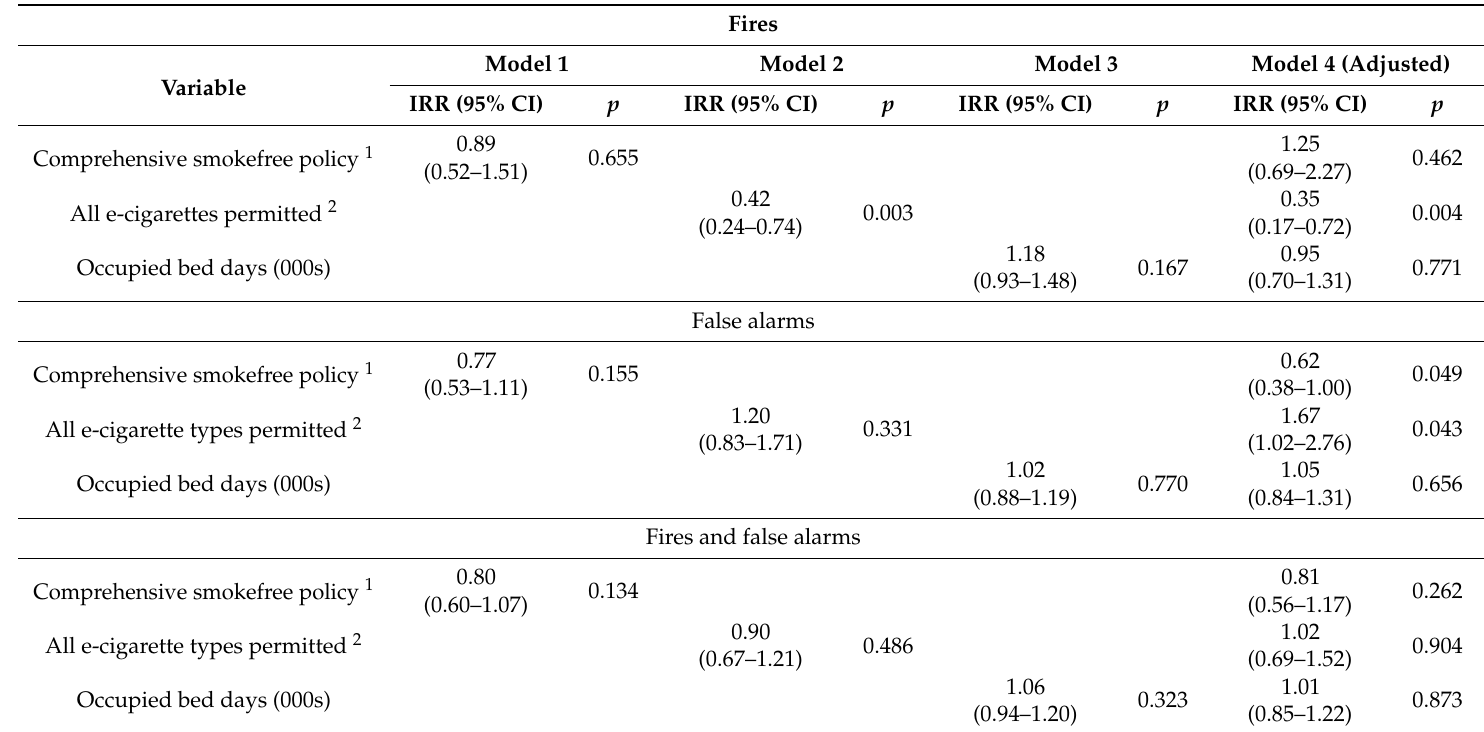
Table 2. Results of unadjusted and adjusted Poisson regression models for associations between smoking policies, and fires, false alarms, and fires and false alarms combined, attributable to inpatients (October 2012–June